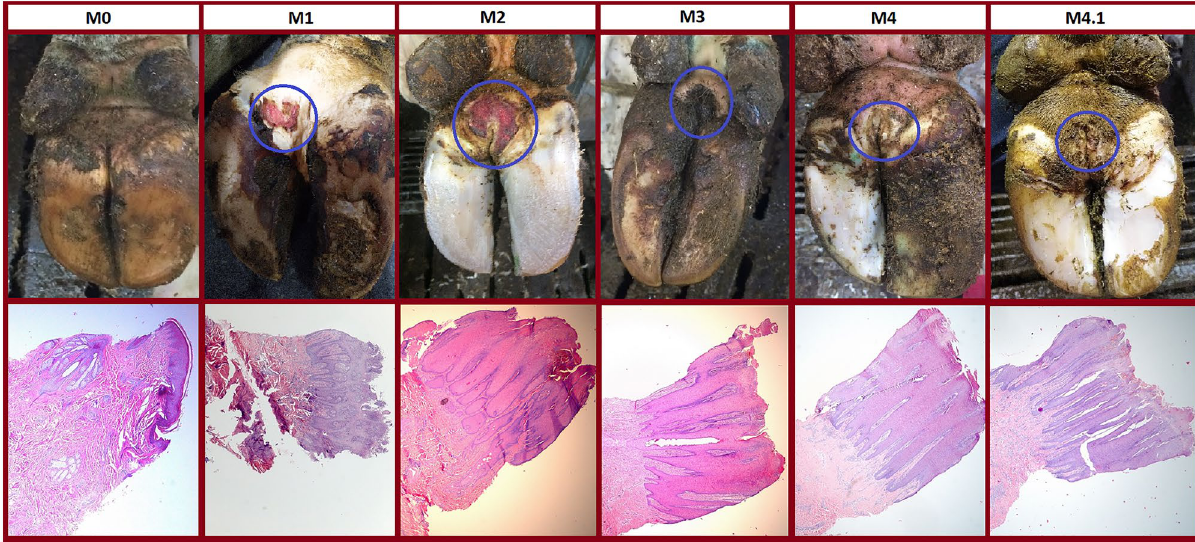
Figure 1. Macro-and microscopical display of all digital dermatitis stages. The top row shows the M-stages, from the healthy skin on the lift to an M4.1 lesion on the right. The lesions are indicated with a circle. The HE stainings of these lesions are displayed in the bottom row (magnification 25×). The separate images have been provided by